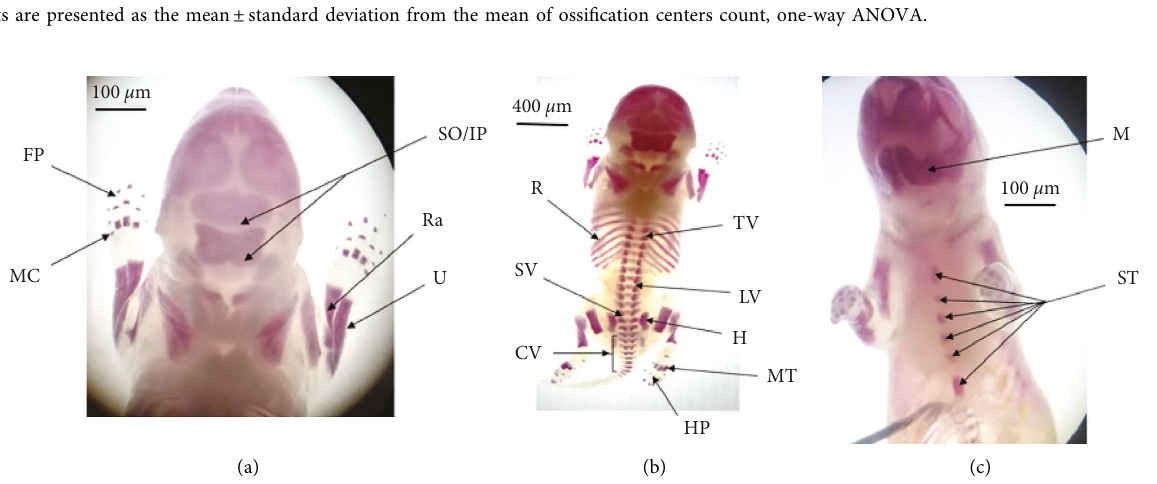
Figure 5: Ossification centers of 20 days old rat fetuses stained with alizarin red. (a) (FP; Forelimb phalanges, IP: interparietal, MC: metacarpus, Ra: radius, So: supraoccipital, and U: ulna). (b) (CV: caudal vertebrae, H: hip bone, HP: hindlimb phalanges, LV: lumbar vertebrae, MT: metatarsus, R: ribs, SV: sacral vertebrae, and TV: thoracic vertebrae). (c) (M: mandible and ST: sternum).